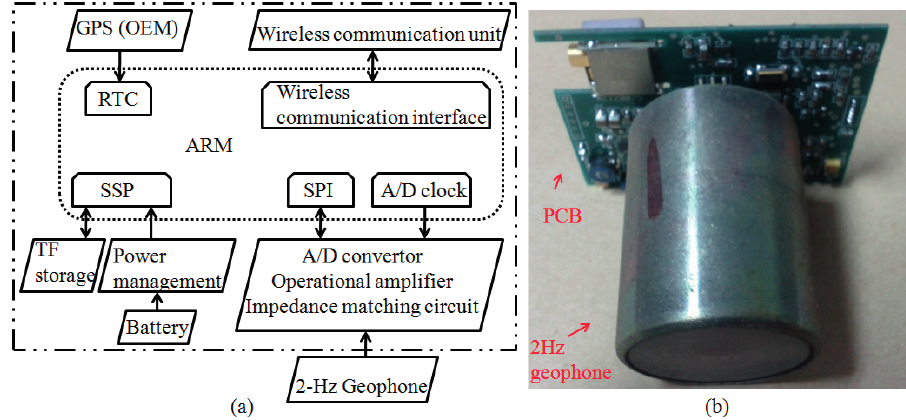
Figure 3. The cableless geophone system: ( a ) Design scheme, and ( b ) integrated unit with the printed circuit board (PCB) and the geophone (see the text for details about the various